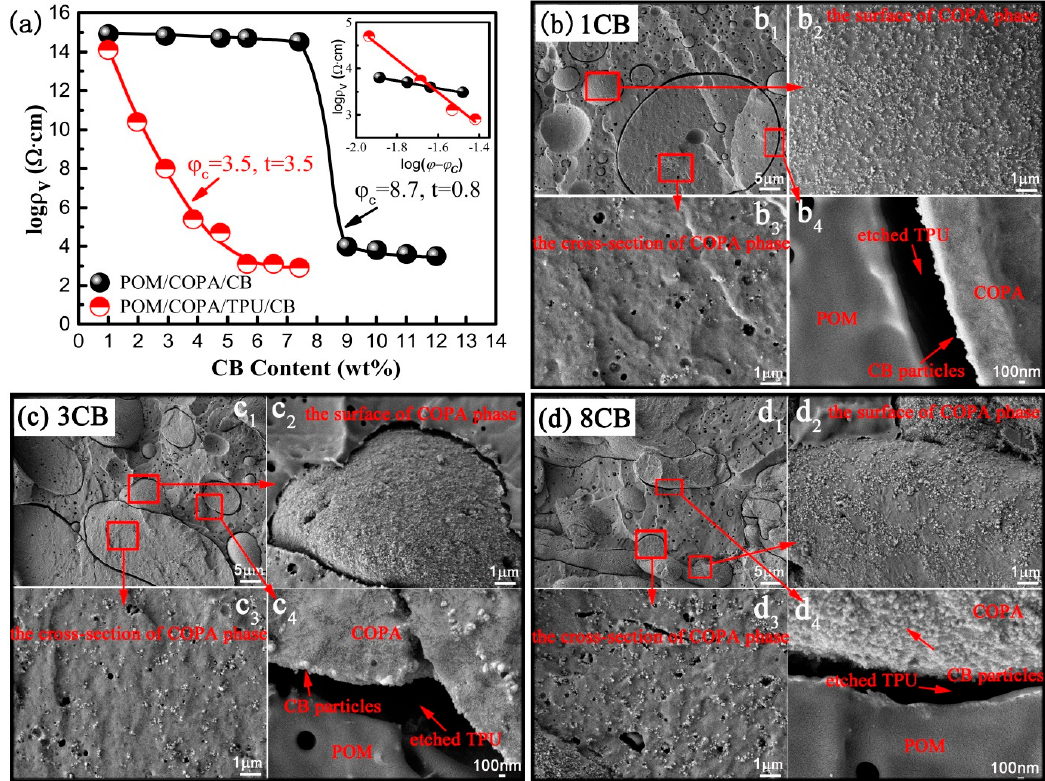
Figure 3. ( a ) Electrical resistivity as a function of CB content for POM/COPA/CB and POM/COPA/TPU/CB composites. The compositions of POM/COPA and POM/COPA/TPU blends were fixed at 70/30 and 65/30/5, respectively. ( b – d ) The FESEM images of the POM/COPA/TPU/CB composites with different CB contents: 1 phr ( b ), 3 phr ( c ), and 8 phr ( d ), and the TPU phase was etched by DMF.